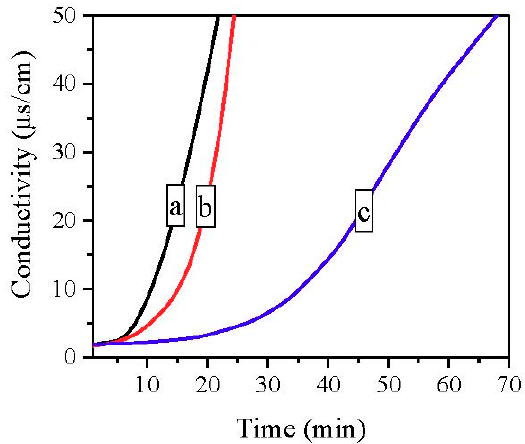
Figure 3. Conductivity versus time plots for ( a ) pure poly(vinyl chloride) (PVC); and PVC stabilized by 4 phr of ( b ) CaSt 2 /ZnSt 2 (1:1); ( c ) DMAE-Zn.